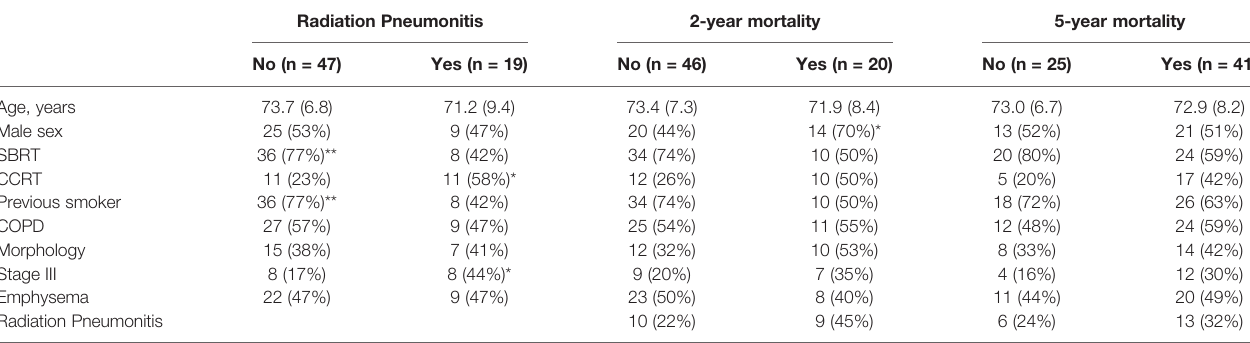
TABLE 2 | Patient characteristics in relation to study